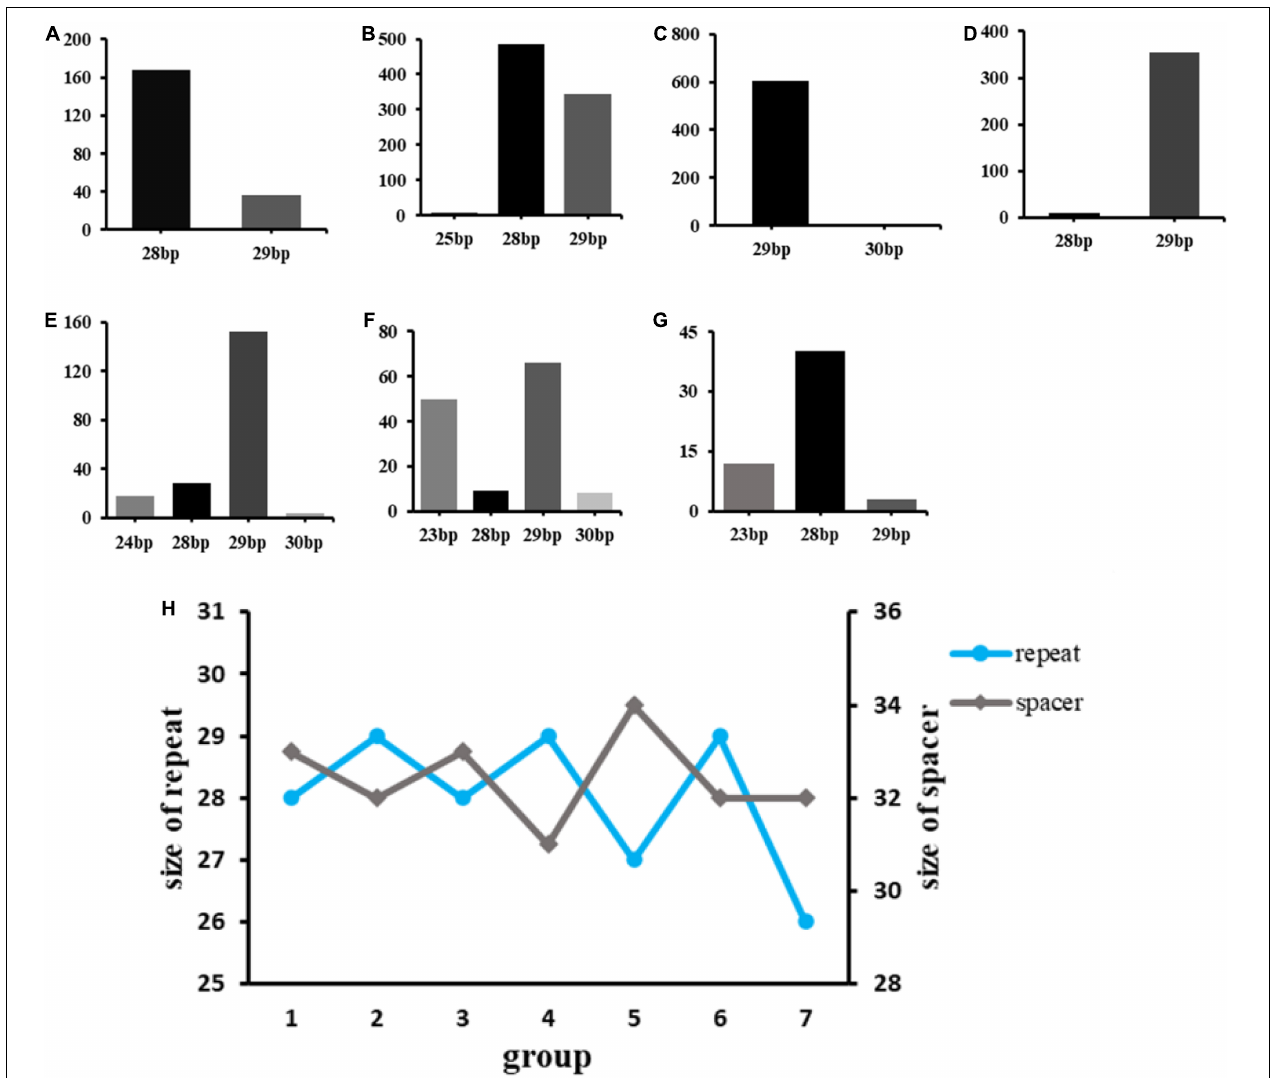
FIGURE 2 | Six Groups of CRISPR spacer size variability. The relationship between the size of repeat and spacer among six groups: (A) Group 1 spacers; (B) Group 2 spacers; (C) Group 3 spacers; (D) Group 4 spacers; (E) Group 5 spacers; (F) Group 6 spacers; (G) Group 7 spacers; (H) The x-axis represents the size of the CRISPR spacers, the y-axis represents the number of the CRISPR spacer. The size of repeat and spacer were inversely